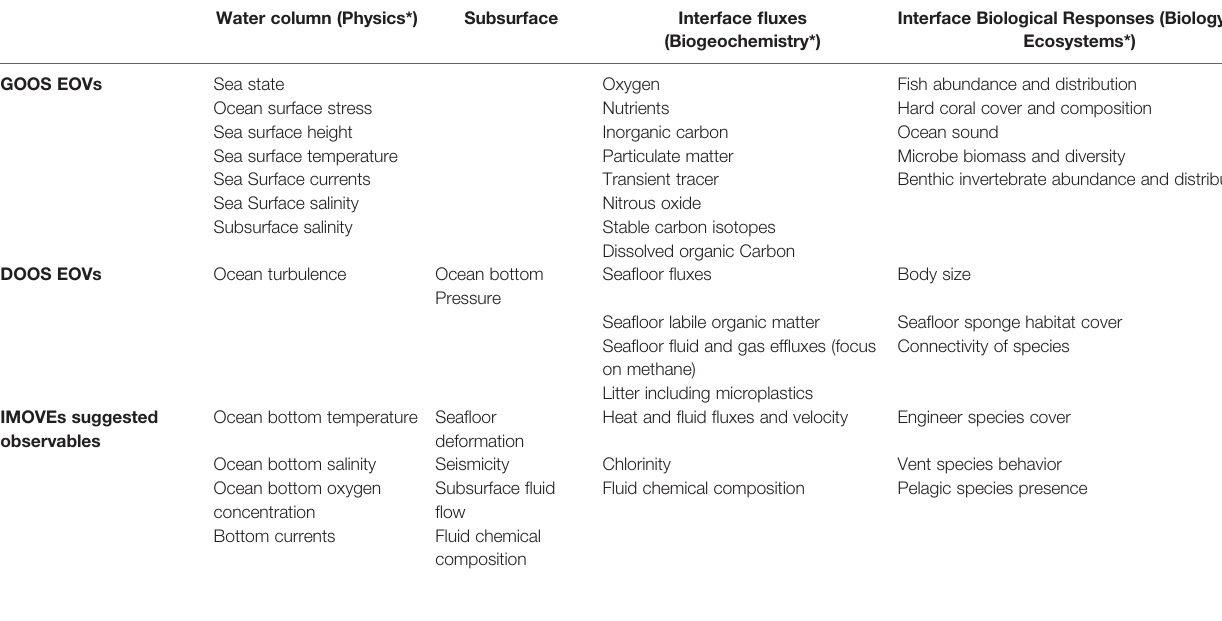
TABLE 3 | Global Ocean Observing System (GOOS) Essential Ocean Variable (EOVs), additional EOVs proposed by the Deep Ocean Observing Strategy (DOOS) and new observables speci fi c to ridges proposed by the InterRidge Integrated Multidisciplinary Observations at Vent Environments that can be measured by sea fl oor vent observatories, their associated surface buoys and/or during annual maintenance cruises (modi fi ed from Levin et al.,